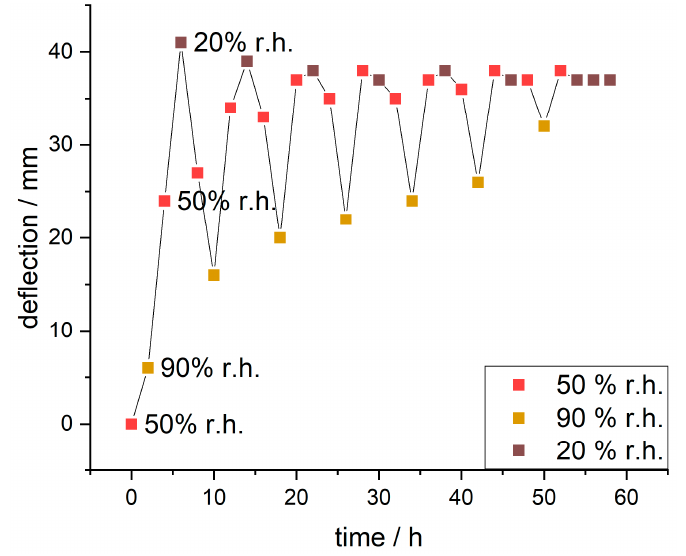
Figure 11. Deflection of a humidity-responsive paper sample (eucalyptus 150 g m − 2 with copolymer from IPA) during changing r.h. over time. After each humidity change, the samples were acclimated for 2 h to reach equilibrium.